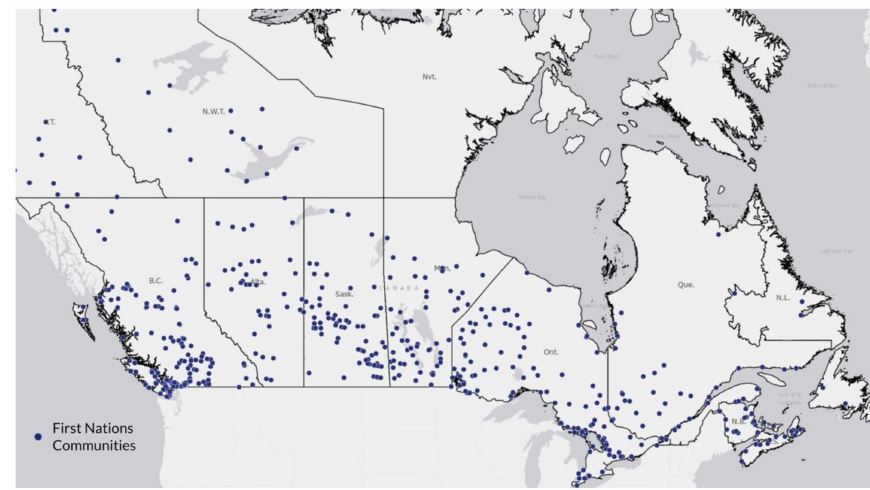
Figure 1. Location of First Nations Communities Across Canada.